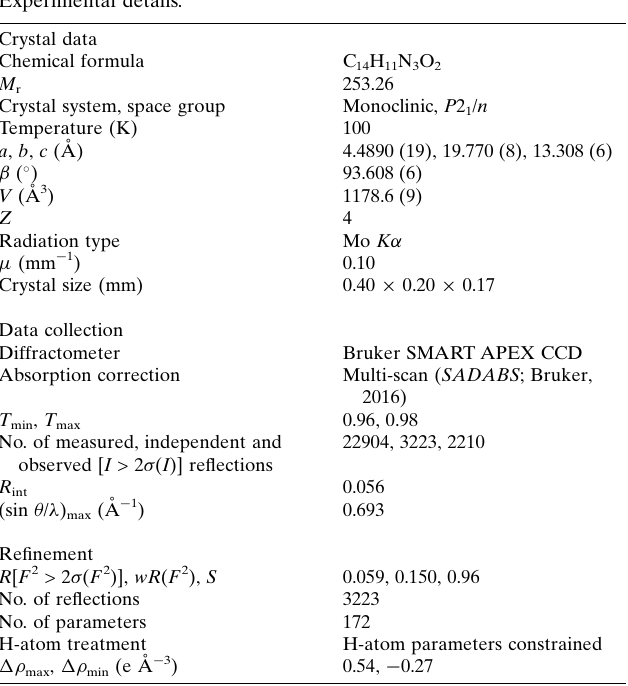
Table 2 Experimental details.